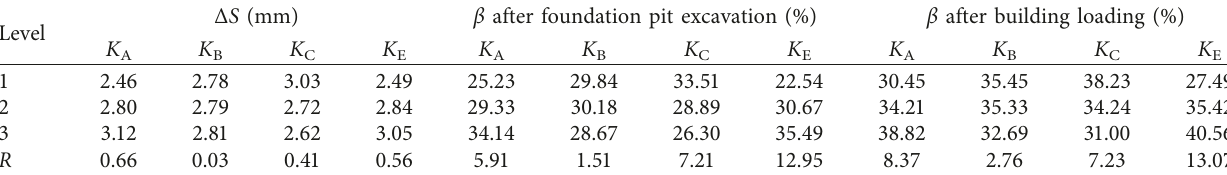
Table 16: Influences of different factors on